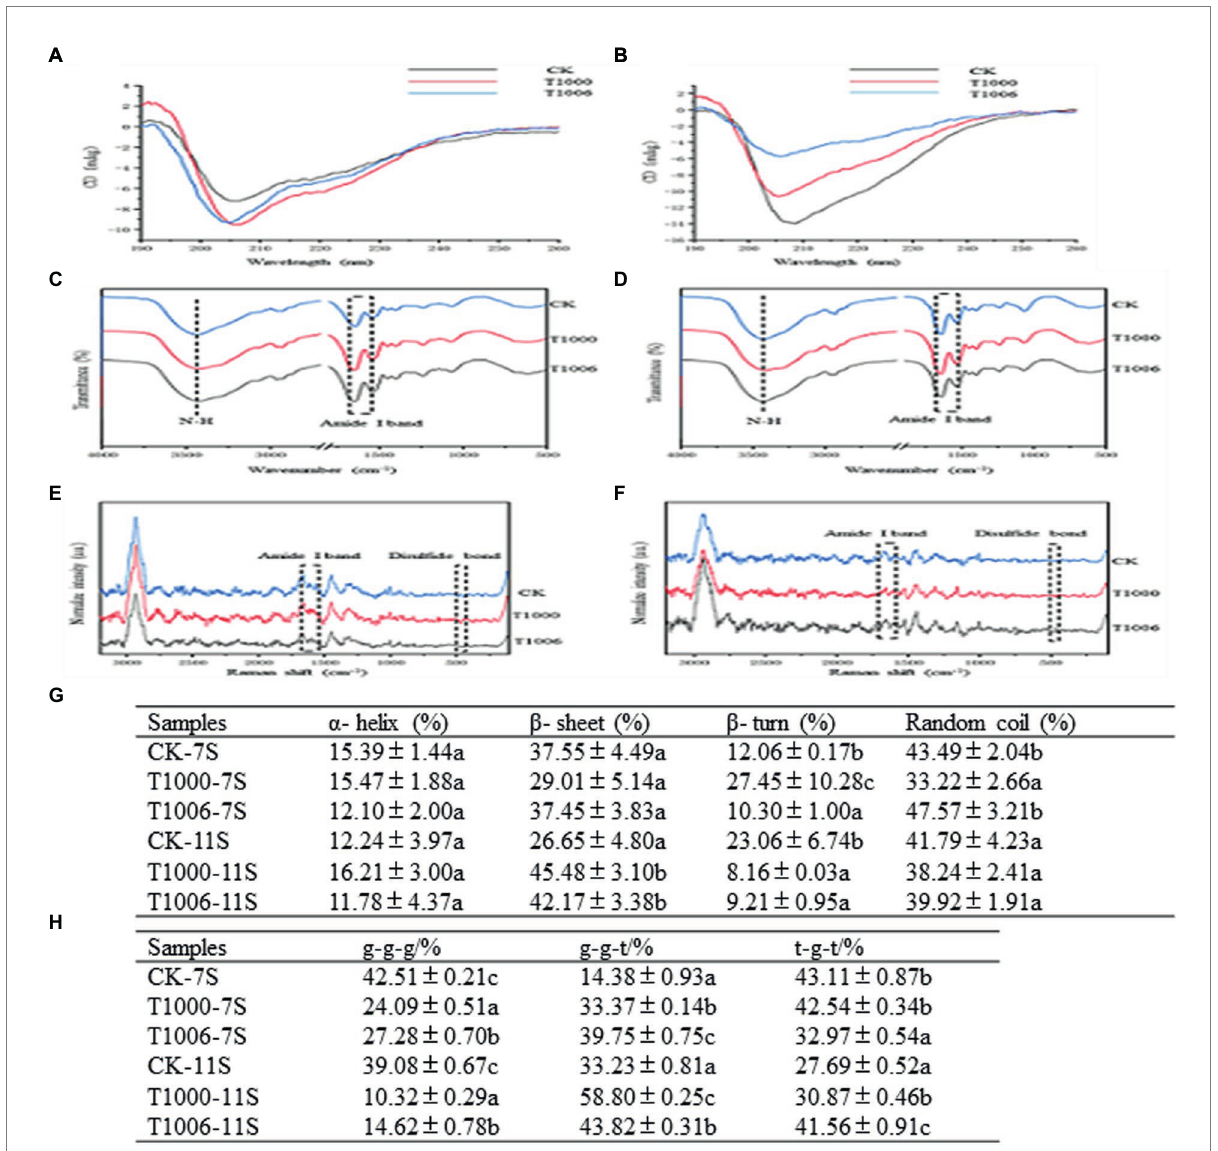
FIGURE 5 Circular dichroism, FTIR and Raman spectra of 7S and 11S isolates from different lines. (A,B) CD spectra; (C,D) FTIR spectra; (E,F) Raman spectra; CK, T1000, T1006 represent the ‘Tianlong No. 1’, T1000, T1006 lines, respectively. (G) Disulfide bond configuration of 7S and 11S fractions from different samples. Different letters indicate the level of significance at the level p = 0.05. (H) Secondary structure content of 7S and 11S fractions from different samples determined by CD, FTIR and Raman spectra. Different letters (a–c) indicate significant differences ( p =